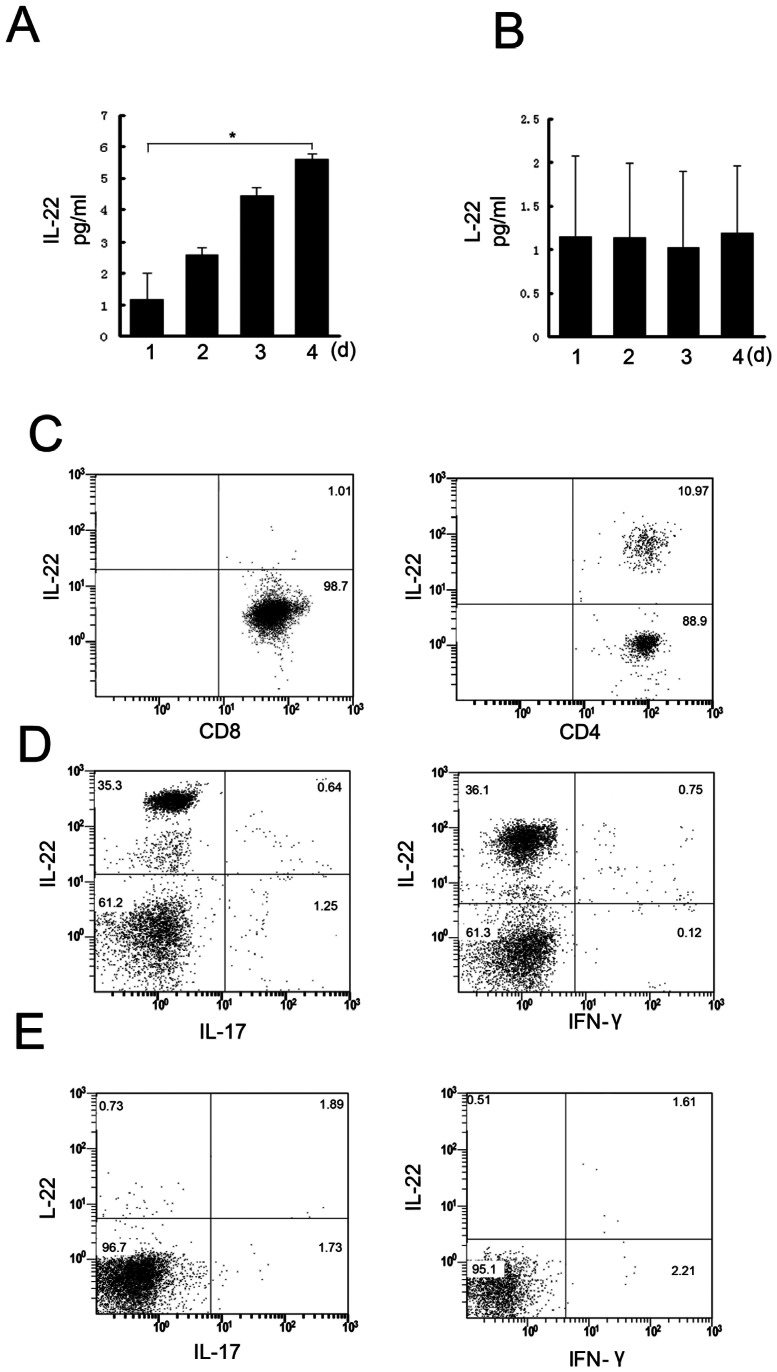
Correlation between IL-22 and Th1, Th17, and Th22 cytokines.(A) Effects of R. pusilluscan infection on PBMC secretion of IL-22 were determined by ELISA. Each symbol represents the mean value of triplicates from a single donor, and the horizontal bars represent the mean of all data points (n = 5/per group), *P<0.05. (B) Effects of R. variabilis infection of PBMC secretion of IL-22 were determined by ELISA. Data are representative of three independent experiments(n = 5/per group). (C–E) Flow cytometry of IL-17, IL-22, IFN-γ and IL-10 in CCR6+CCR4+CXCR3− cells, sorted as CCR10+ and CCR10+ cells, after six days of in vitro expansion and restimulation with TPA and ionomycin. Numbers in quadrants indicate percent cells in each. Data are representative of three independent experiments.